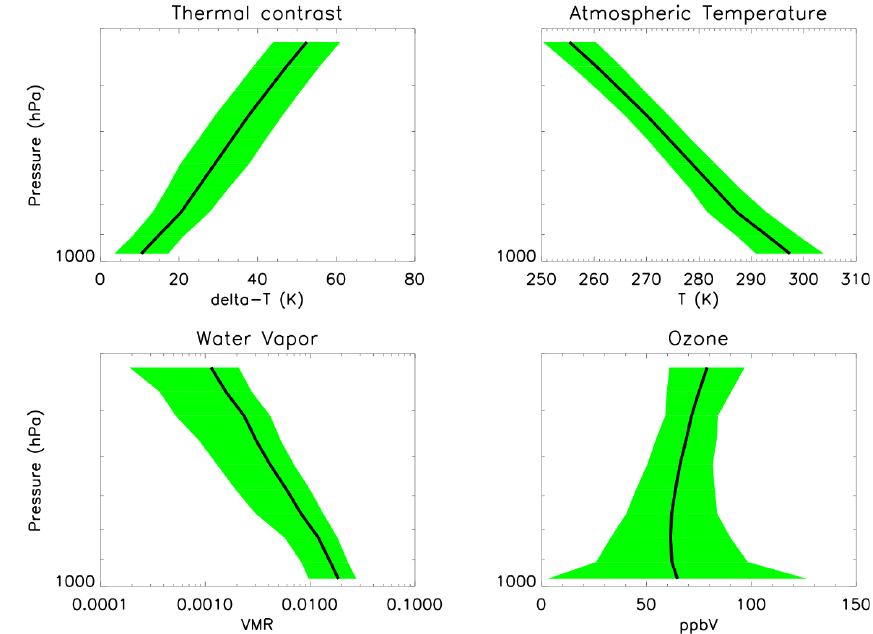
Figure 8. Same as Fig. 7 but for TES-OMI pressure dependent state parameters. Fig. 8. Same as Fig. 7 but for TES-OMI pressure-dependent state